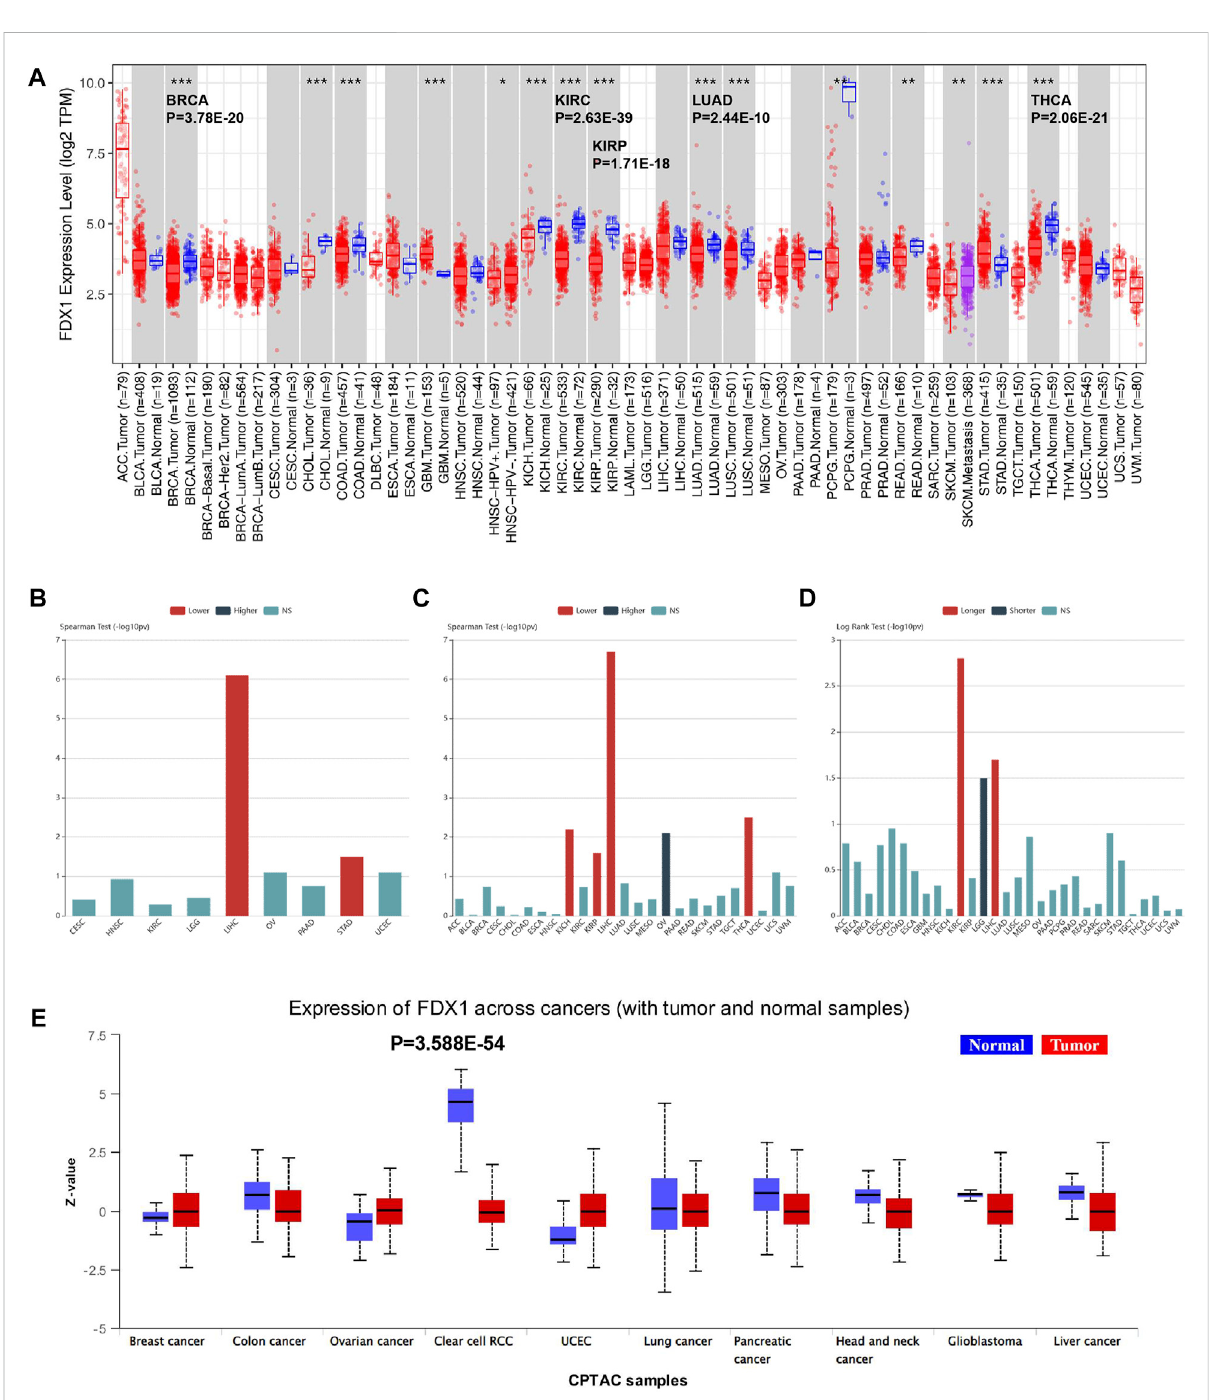
FIGURE 1 TCGA study of FDX1 RNA and protein expression and correlation with clinical characteristics. (A) Pan-cancer relative of human FDX1 mRNA expression across 33 TCGA cancers in TIMER. The statistical signi fi cance is annotated by the number of stars (* p < 0.05, ** p < 0.01, *** p < 0.001 and **** p < 0.0001). (B) Associationsbetween FDX1mRNA leveland patientpathological gradeindifferentcancersinTISIDB. (C) Signi fi cantassociations between FDX1 expression and stage across cancers (Spearman correlation test p 0.05). (D) Associations between FDX1 expression level and overall survival among human cancers. (E) FDX protein expression of tumour vs. normal samples across human tumours based on CPTAC (clinical proteomic tumour analysis consortium) analysis. Z-values show standard deviations from the median across samples for the speci fi ed cancer type. NS, not signi fi